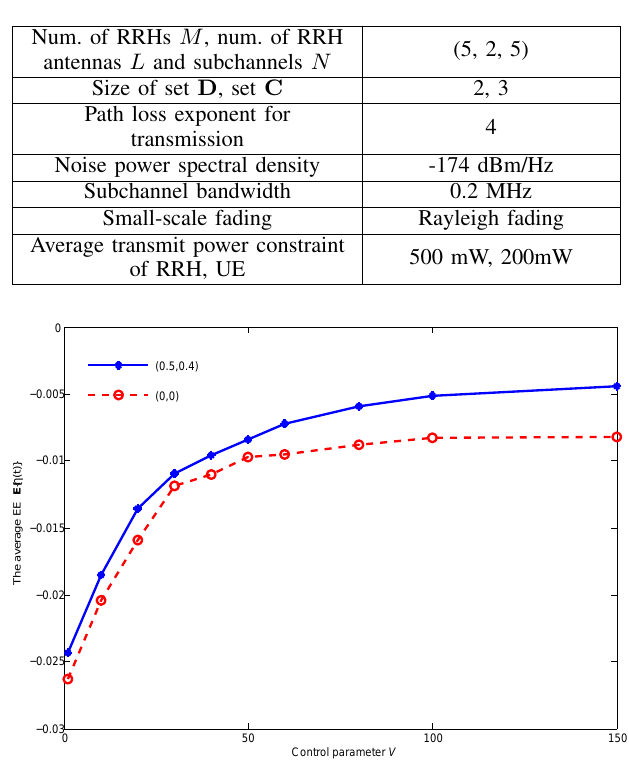
Fig. 4. The average EE of systems versus the control parameter V under different cache control variables ( q { 1 }